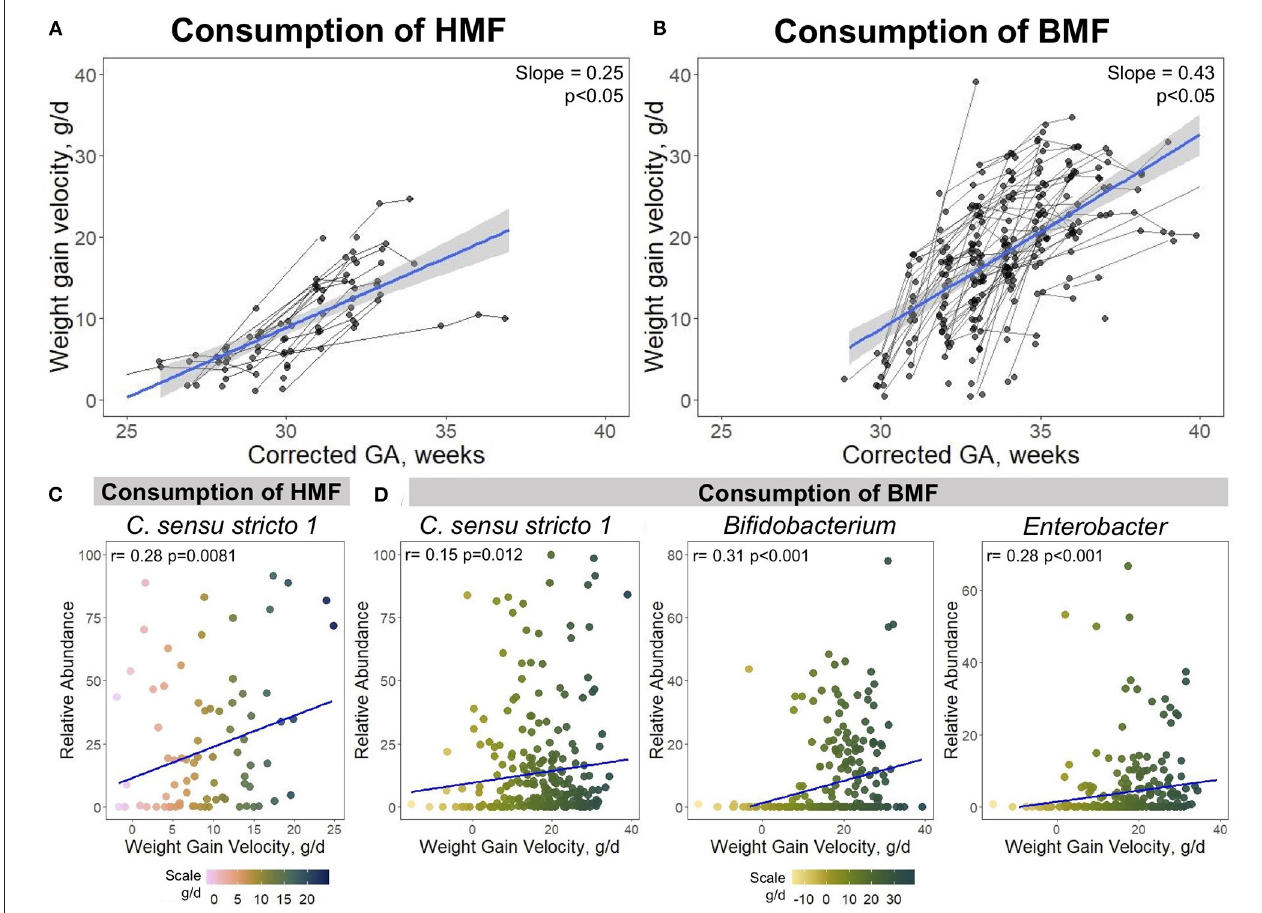
FIGURE 6 | Associations between growth velocity, use of fortifiers and taxonomic composition. The use of HMF and BMF are associated with the infant’s growth and their taxonomic composition. (A) Growth curves of PT infants when consuming HMF, or (B) BMF. Spearman correlations showing positive associations between Clostridium sensu stricto 1 , Bifidobacterium , and Enterobacter with weight gain velocity when infants were exposed to (C) HMF or (D) BMF. Corrected GA: gestational age at birth + postnatal age. GA, gestational age; HMF, human milk-based fortifier; BMF, bovine milk-based